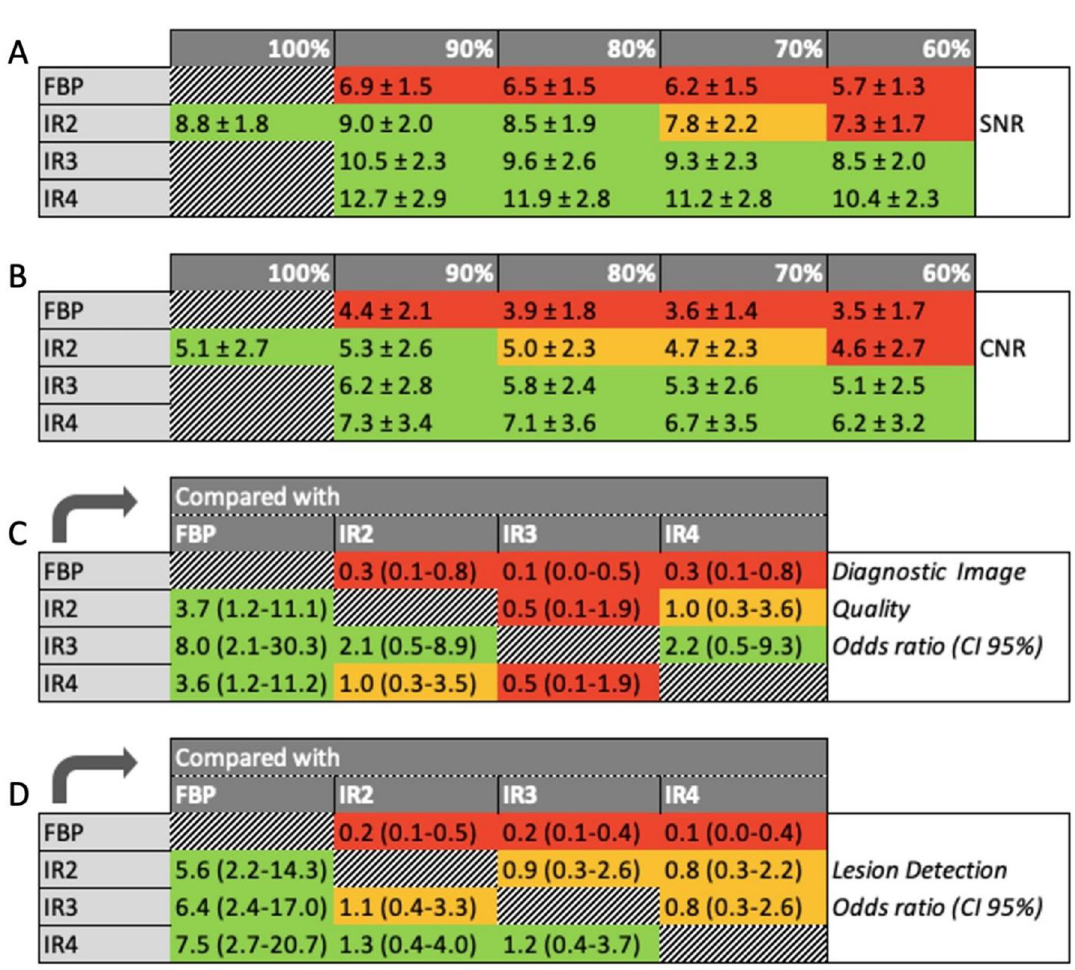
Fig 1. A signal to noise ratio (SNR) of 8.0 (A) and contrast to noise ratio (CNR) of 5.0 (B) were considered diagnostic. A and B show the corresponding SNR and CNR for each combination of iterative reconstruction (IR) strength and percentage of the initial value of the tube current. In green the combinations leading to diagnostic objective image quality. In part C and D, the odds ratios of the overall diagnostic image quality (C) and the lesion detection capability (D) are set out. Filtered back projection (FBP) and IR strengths on the left are compared to the reconstruction methods on the x-axis. For example, the odds that IR 4 results in a better lesion detection than IR 3 is 1.2, with a confidence interval (CI) of